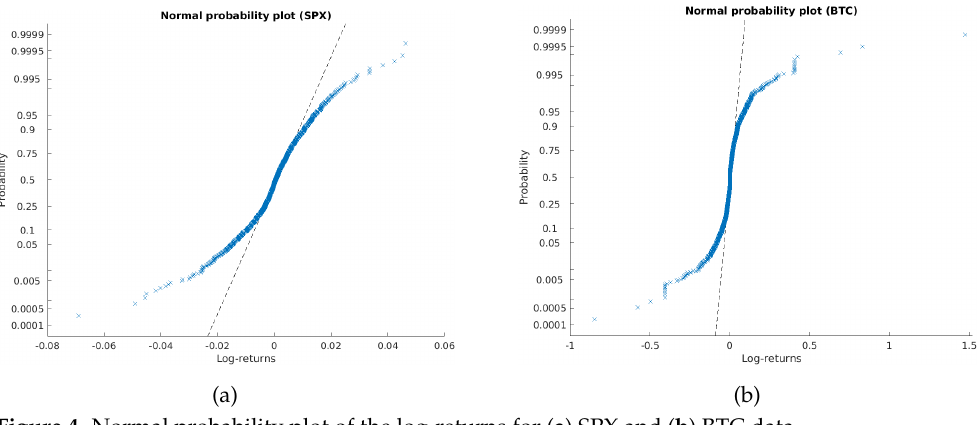
Figure 4. Normal probability plot of the log-returns for ( a ) SPX and ( b ) BTC data. Table 3. Mean, standard dev., skewness and kurtosis of the SPX and BTC standardized residuals. Mean ( ˆ ε ) St.dev. ( ˆ ε ) Skewness ( ˆ ε